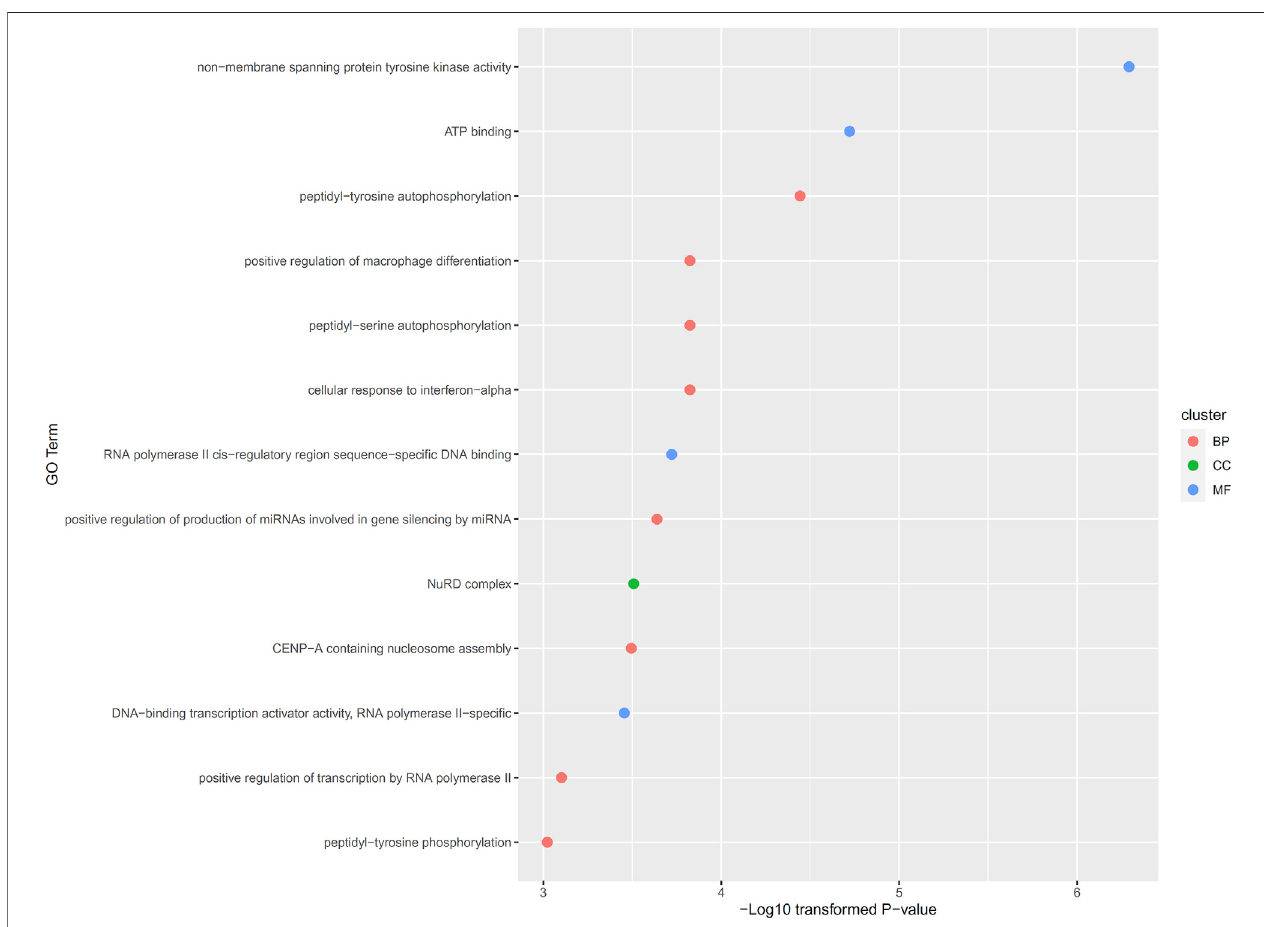
FIGURE 3 | Enriched gene ontology (GO) terms on inferred genes. Thirteen GO termed are enriched on 108 inferred genes, including eight biological processes (BP) terms, four molecular function (MF) terms and one cellular component (CC) term.